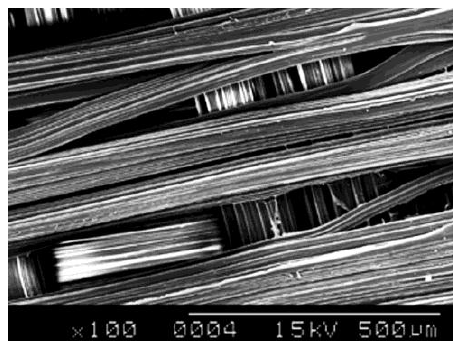
Figure 2. Scanning electron micrograph of the chitosan-based HA hybrid polymer fibers